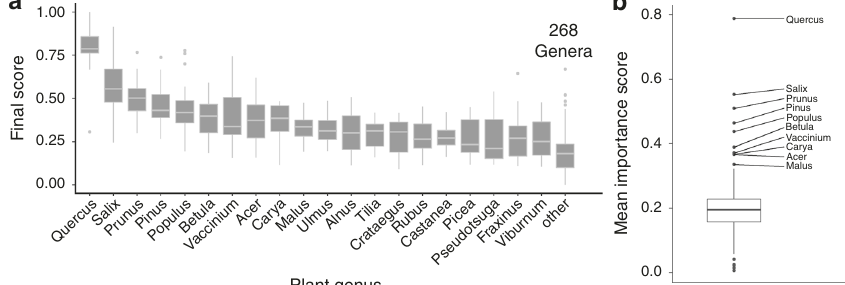
Fig. 2 Some plant genera are disproportionately important for supporting host plant- Lepidoptera interaction networks. a Mean importance scores for the top 20 plant genera (plants with the highest scores that are also present in three or more counties) and all other plants combined. Importance scores were calculated as the standardized rank score that combined (1) the number of Lepidoptera species hosted, (2) the number of specialized Lepidoptera species supported (species that only use one plant genus), and (3) the effect on network stability. b Mean importance scores for the 198 woody plant genera that support at least one Lepidoptera species included in the keystone plant network analysis. 10 plant genera were identi fi ed as outliers (>1.5* interquartile range). Plant genera not known to support any Lepidoptera species were excluded from this graph ( n = 90). All box plots show the median (center line), fi rst and third quartile (upper and lower hinges), and 1.5 * interquartile range